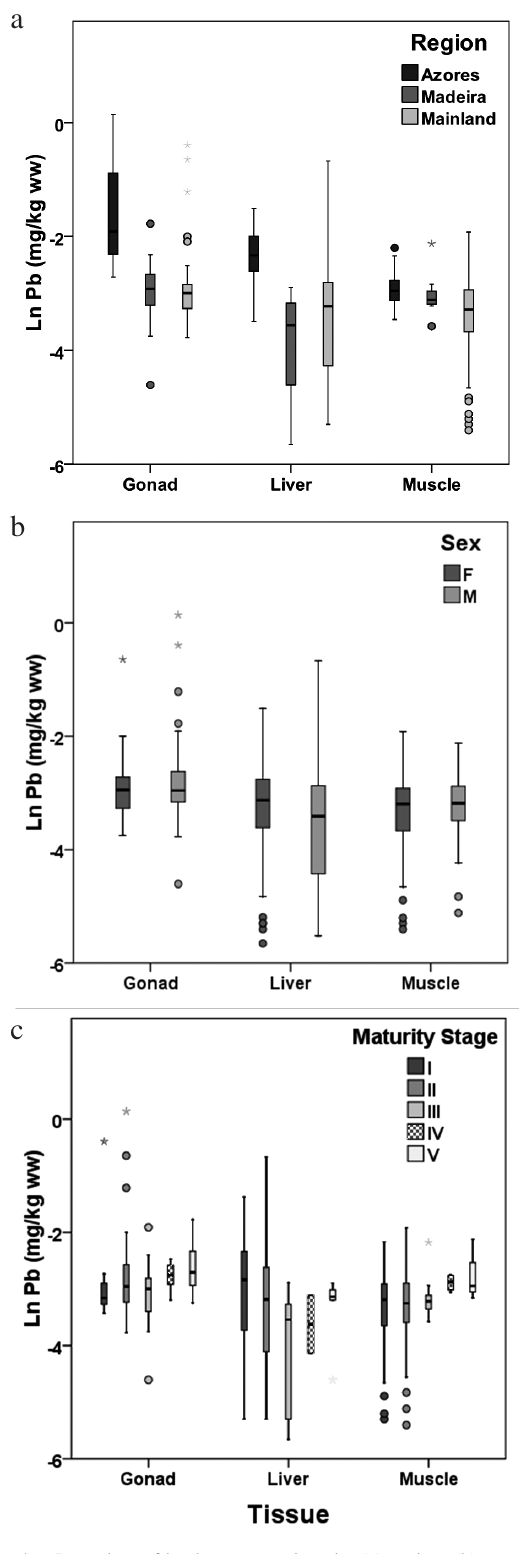
Fig . 4. – box plots of lead concentrations by (a) region, (b) sex, and (c) maturity stage. each box plot presents the median, the 1 st and 3 rd quartiles, the maximum and the minimum. the circles correspond to the outliers and the asterisks are the extreme